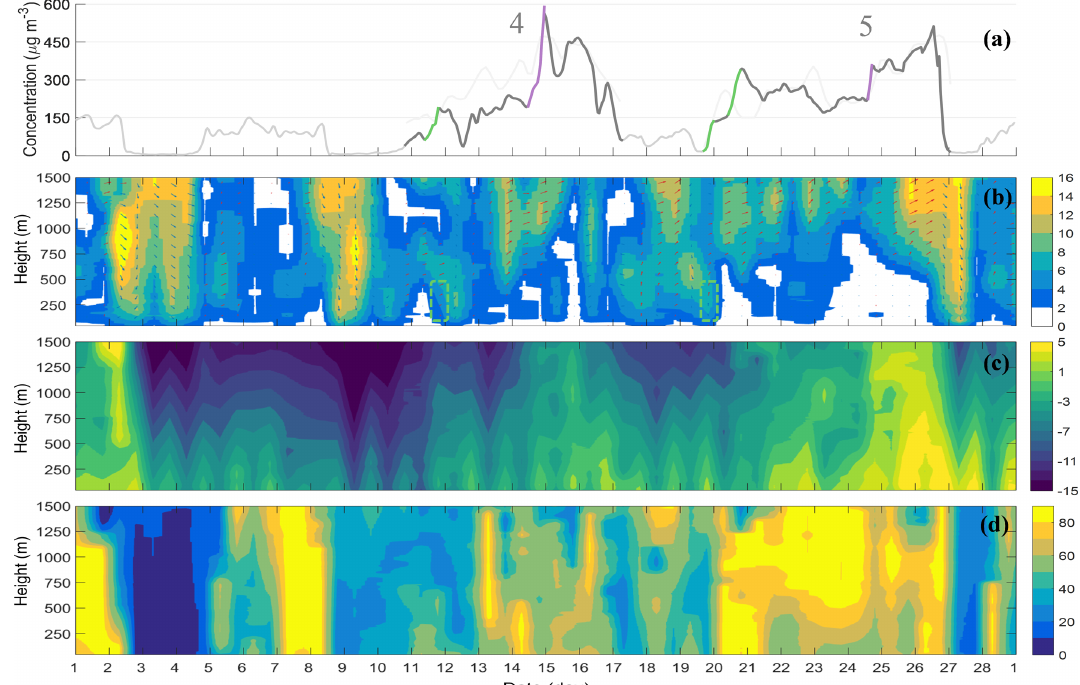
Figure 2. Temporal variations in urban mean PM 2 . 5 and vertical distributions of meteorological factors in February 2014. (a) PM 2 . 5 mass concentration (dark gray or gray: Beijing; light gray: Baoding); (b) winds (vectors; red vectors: southwesterly winds) and wind velocity (shadings; units: ms − 1 ); (c) temperature (shadings; units: ◦ C); (d) RH (shadings; units: %). Green boxes: rising processes.